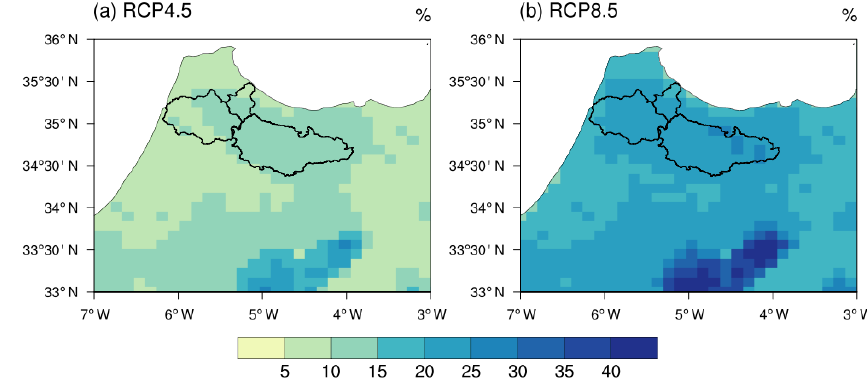
Figure 10. Future changes in PET computed using the Penman–Monteith equation and RCMs following RCP4.5 (a) and RCP8.5 (b) , respectively. The three watersheds of interest are shown using contours.